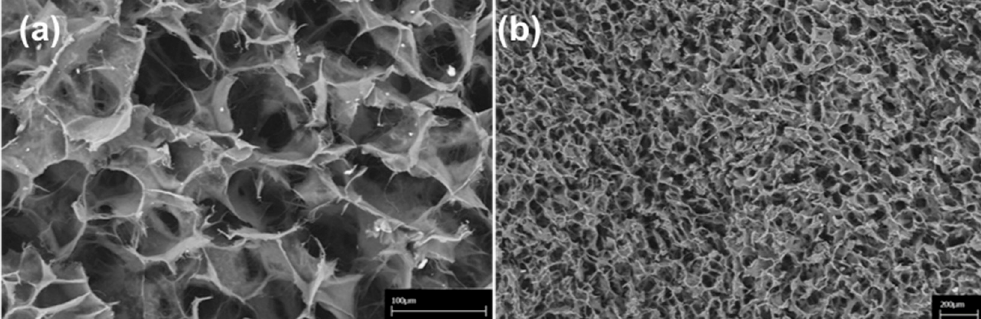
Figure 1. Scanning Electron Microscopy (SEM) images of the collagen-based scaffold. At higher magnification, interconnected collagen fibres are detectable within the scaffold. Scale bars: 100 μ m in ( a ); 200 μ m in ( b ).